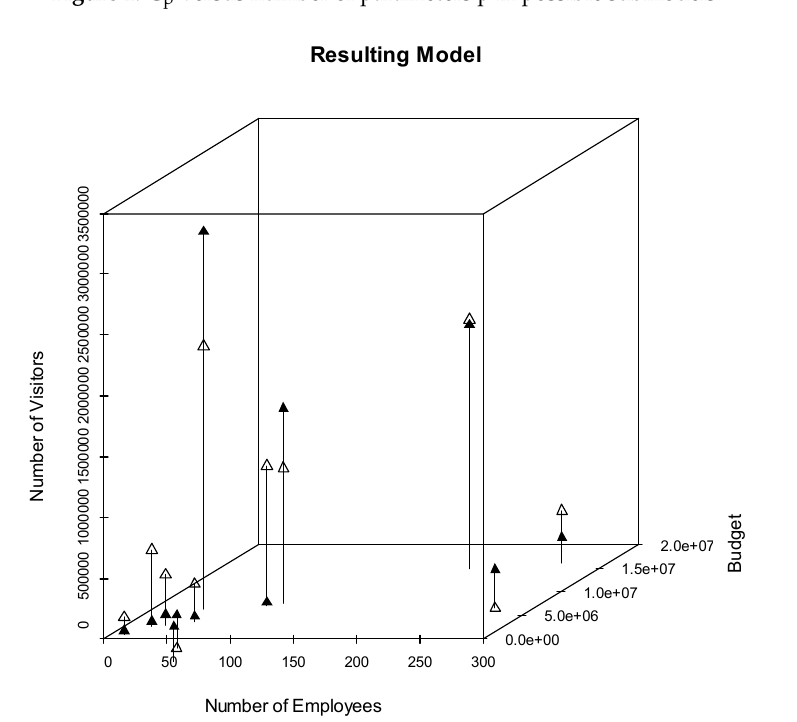
Figure 2. Number of visitors versus two important predictors. Notes: Full triangles represent empirical data and empty triangles represent the resulting model (5).